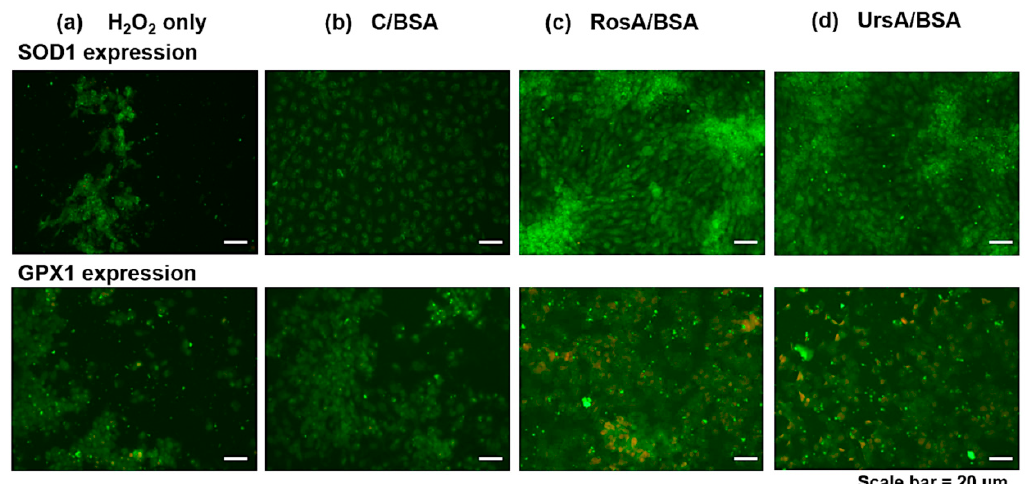
Figure 9. The results of immunofluorescent imaging examination of SOD1 and GPX1 protein expression in the ARPE cells. First, the cells were incubated with drug formulations ( b : C/BSA, c : RosA/BSA, and d : UrsA/BSA) at 50 µM and then H 2 O 2 . The cells were incubated with antibodies to detect each antioxidant protein type. The images of cells treated with ( a ) H 2 O 2 only are also displayed with the scale bar 20 µm.